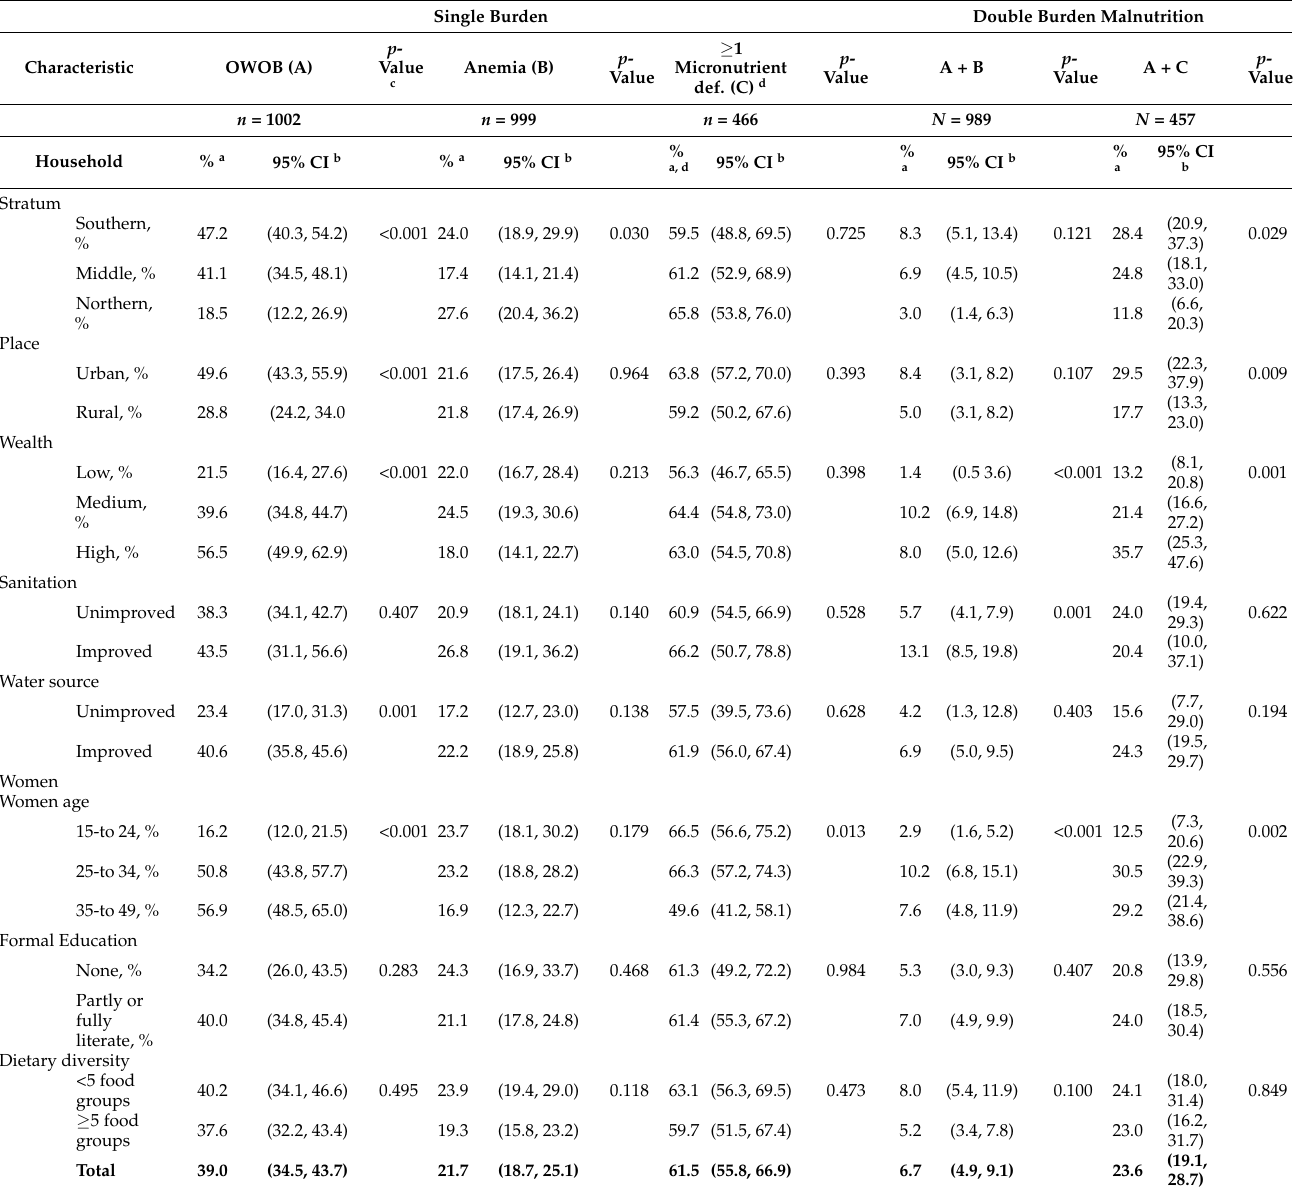
Table 2. Prevalence of overweight/obesity, anemia, micronutrient deficiency and co-occurrence of overweight/obesity with anemia or micronutrient deficiency among non-pregnant women 15–49 years of age in